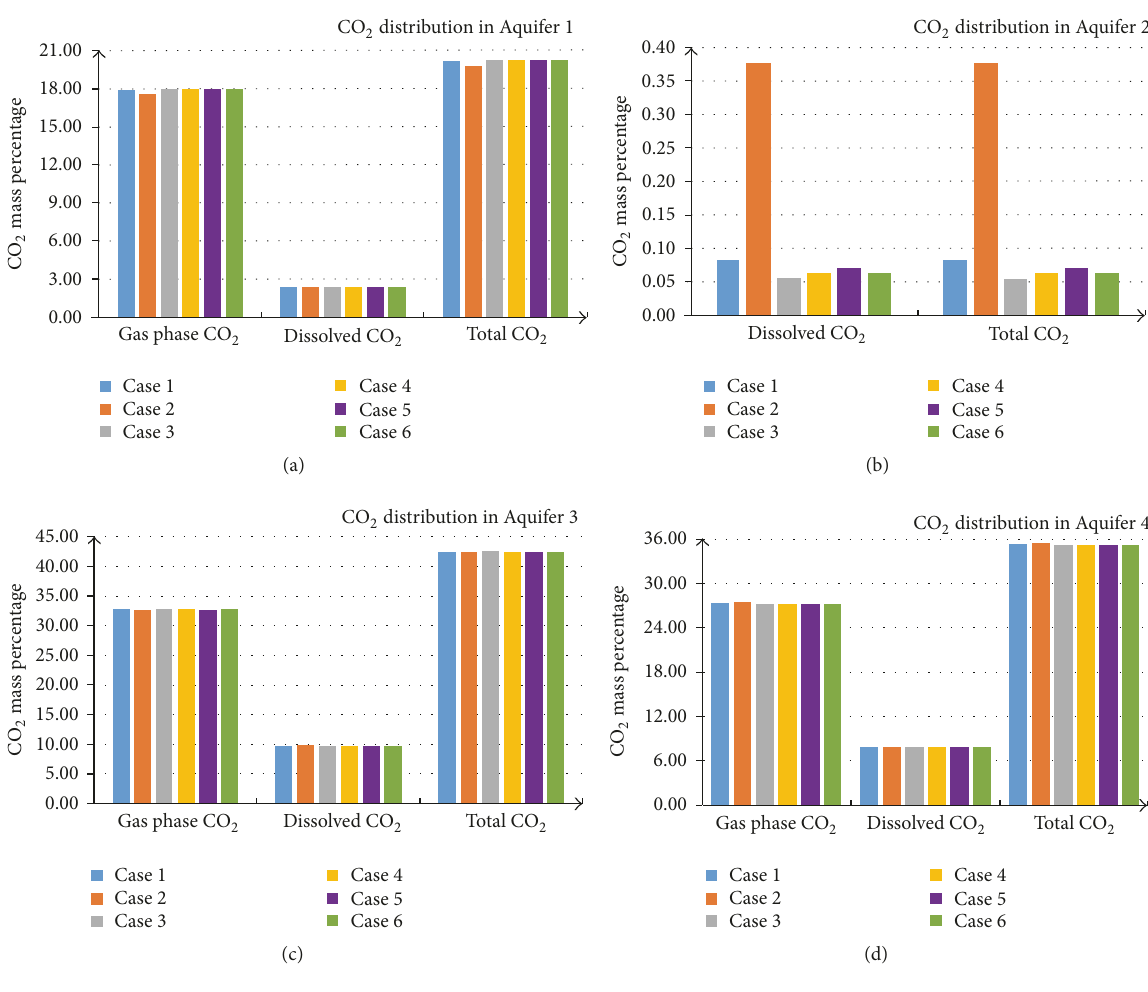
Figure 16: CO 2 mass distribution into each aquifer at the end of 5 year’s injection in